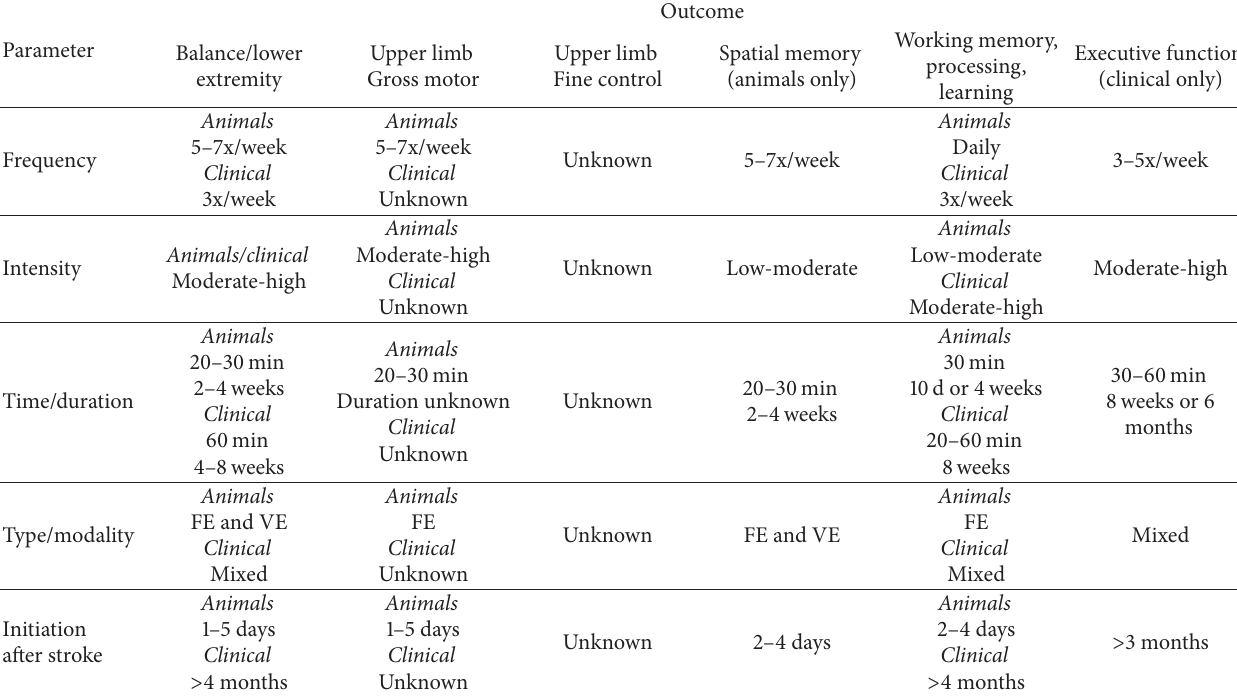
Table 2: Synthesized findings of optimal parameters to affect stroke